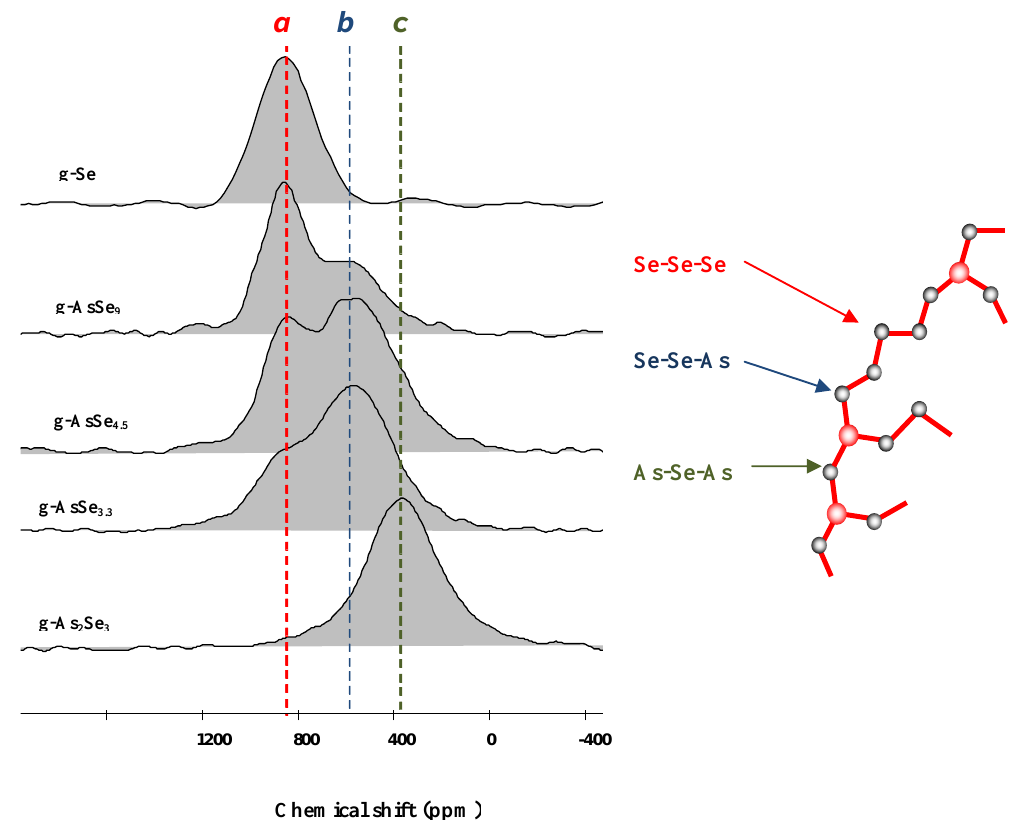
Figure 3. 77 Se solid state NMR spectra [17] in the As/Se system, showing the presence of three environments around the selenium: two selenium, two arsenic and one arsenic with one selenium. The NMR data are in good agreement with the expected classical model exhibiting a dimensionality between 1D (chains) and 2D